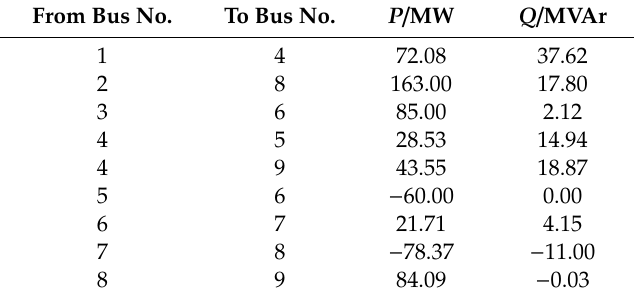
Table 2. Power flow